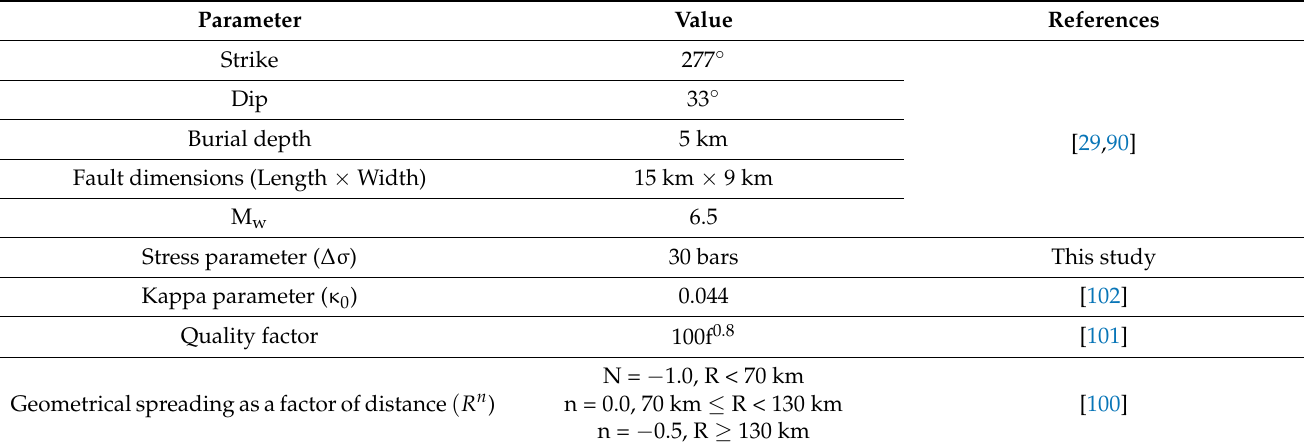
Table 1. Modeling parameters used for the stochastic ground motion simulation of the M w = 6.5 Aigion 1995 mainshock performed with the EXSIM code.